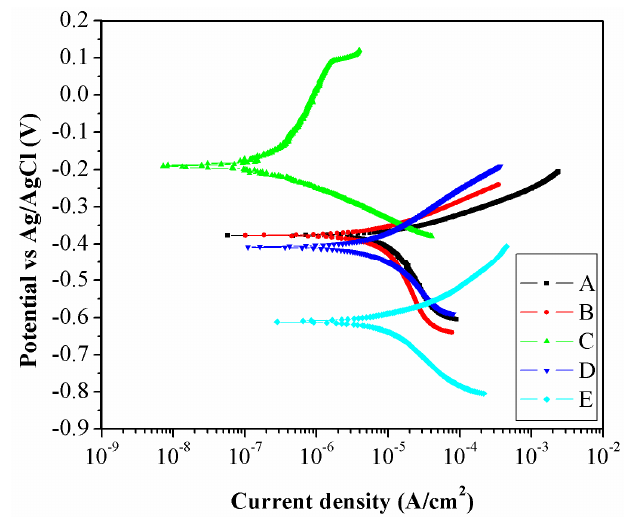
Figure 10. Potentiodynamic polarization curves of the five zones of the weld.